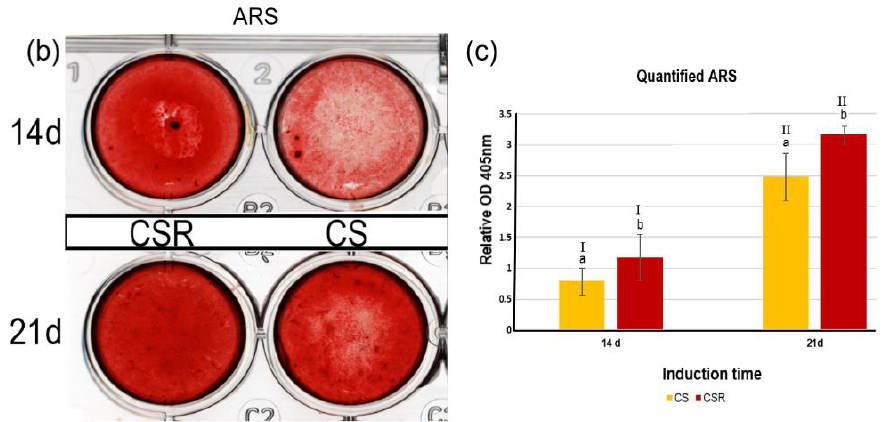
Figure 7. ( a ). ALP activity of CS and CSR after culturing for 3 d, 7 d, and 14 d. Regular medium (RM) and differentiation medium (DM) served as negative and positive controls, respectively. Figure 7. ( b ). Scanned plates showing mineralization nodules stained by ARS in the induced cultures at 14 d and 21 d in both CS and CSR. ARS was more intense in CSR than CS at both induction time points. Quantification of the mineralized nodules by ARS revealed higher OD values in CSR than CS ( c ). Different lowercase letters indicate significant difference between groups within each induction time point, while Roman numbers I, II, III indicate difference between each group at different induction time points, p < 0.05.